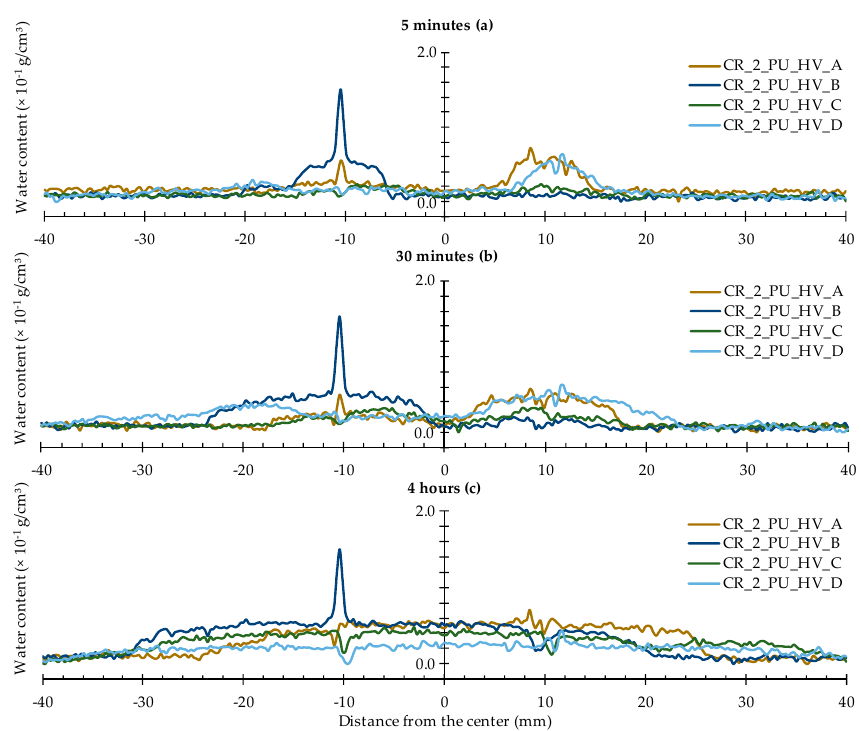
Figure 14. Water profiles of the four standard mortar prisms containing two artificial cracks healed with PU_HV: ( a ) after 5 min; ( b ) after 30 min; and ( c ) after 4 h.